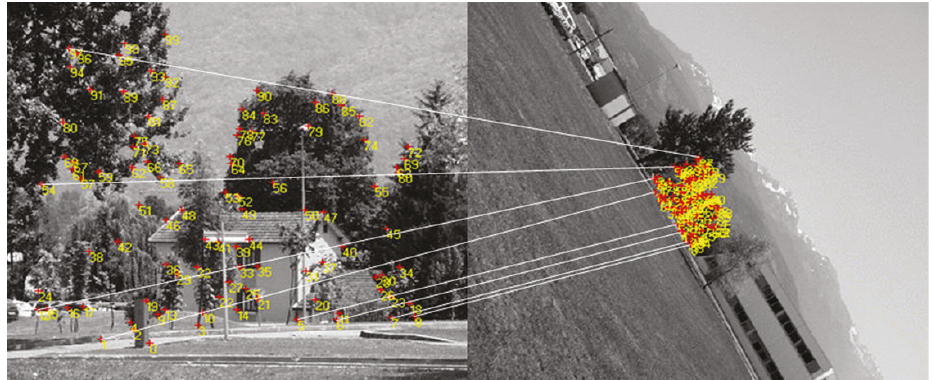
Figure 11: Matching result for image pair East south (frames 0 and 9 of “East south” sequence). The scale factor is 5.2, and the rotation angle is 59 degrees.